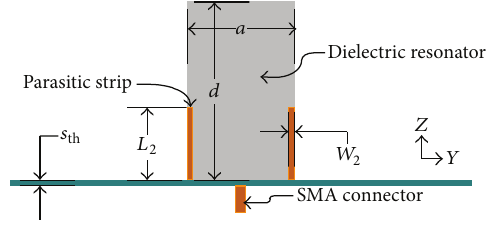
Figure 3: Proposed DRA structure ( 𝑌𝑍 plane).